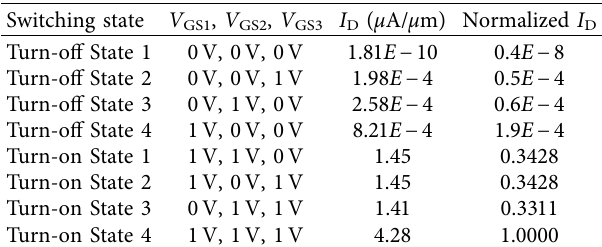
Figure 4: DC characteristics of the Ti-TFETin different modes: (a) the DC transfer characteristics as the gate-to-source voltage V DC transfer characteristics as the gate-to-source voltage V GS3 , and (c) the transfer characteristic of the N-type Ti-TFET with shorted Table 2: The turn-on and turn-off currents of the N-type Ti-TFET device.